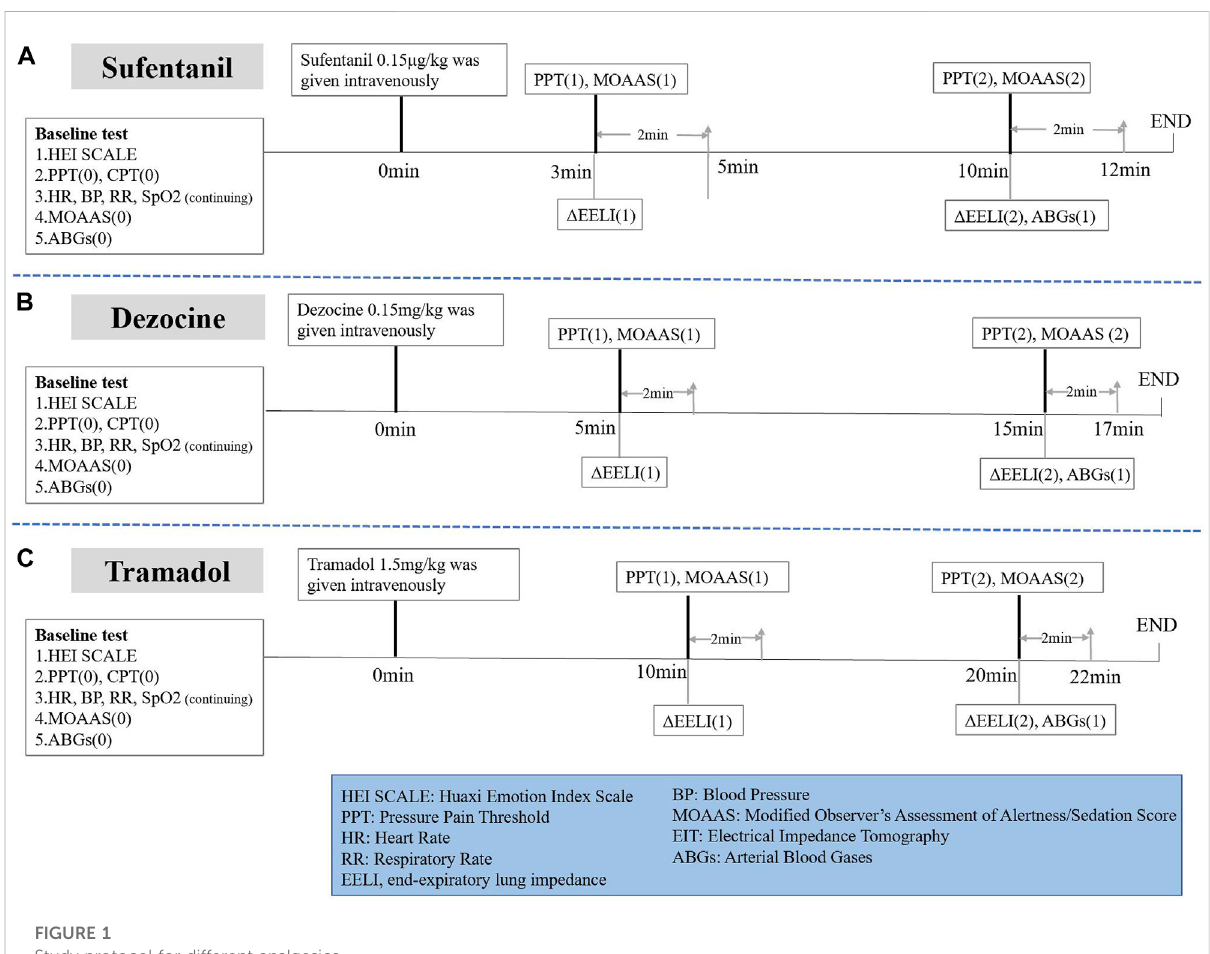
FIGURE 1 Study protocol for different